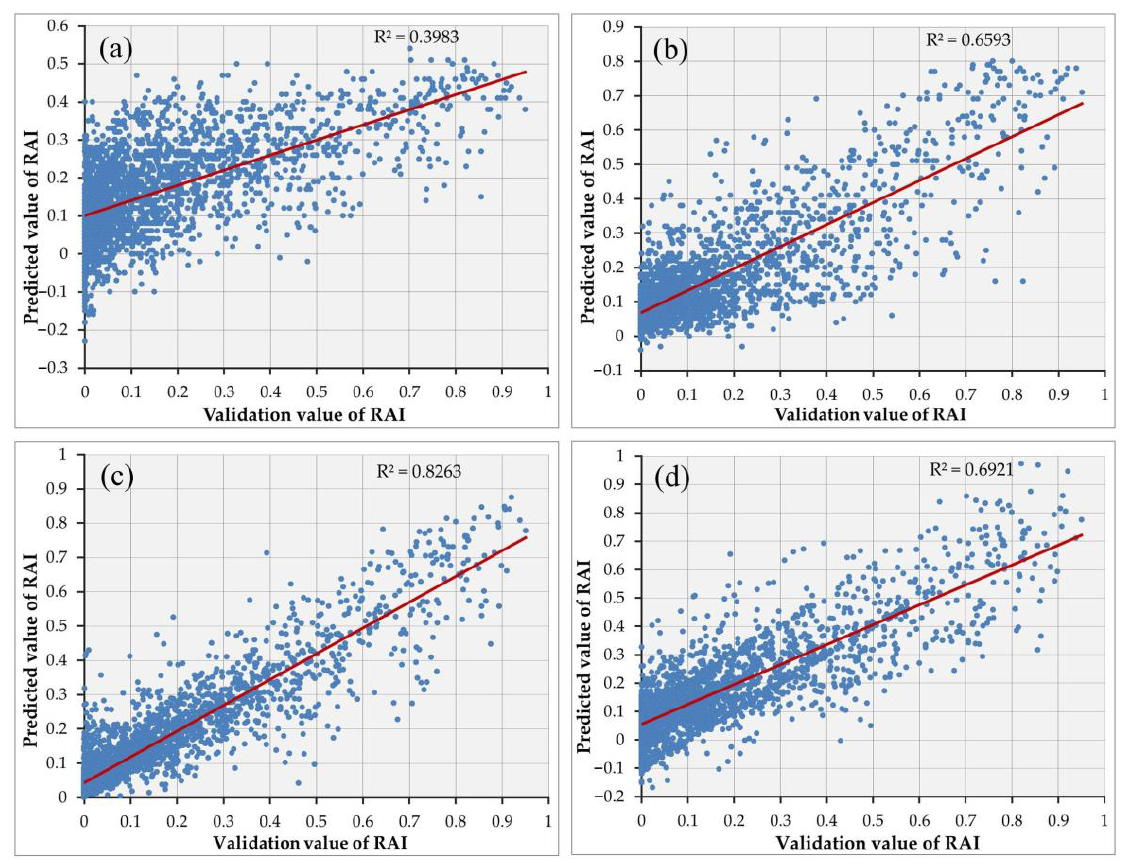
Figure 7. Comparison between the measured and predicted RAI using: ( a ) the MLR model; ( b ) the MLP neural nets model; ( c ) the RF model; and ( d ) the SVR model.